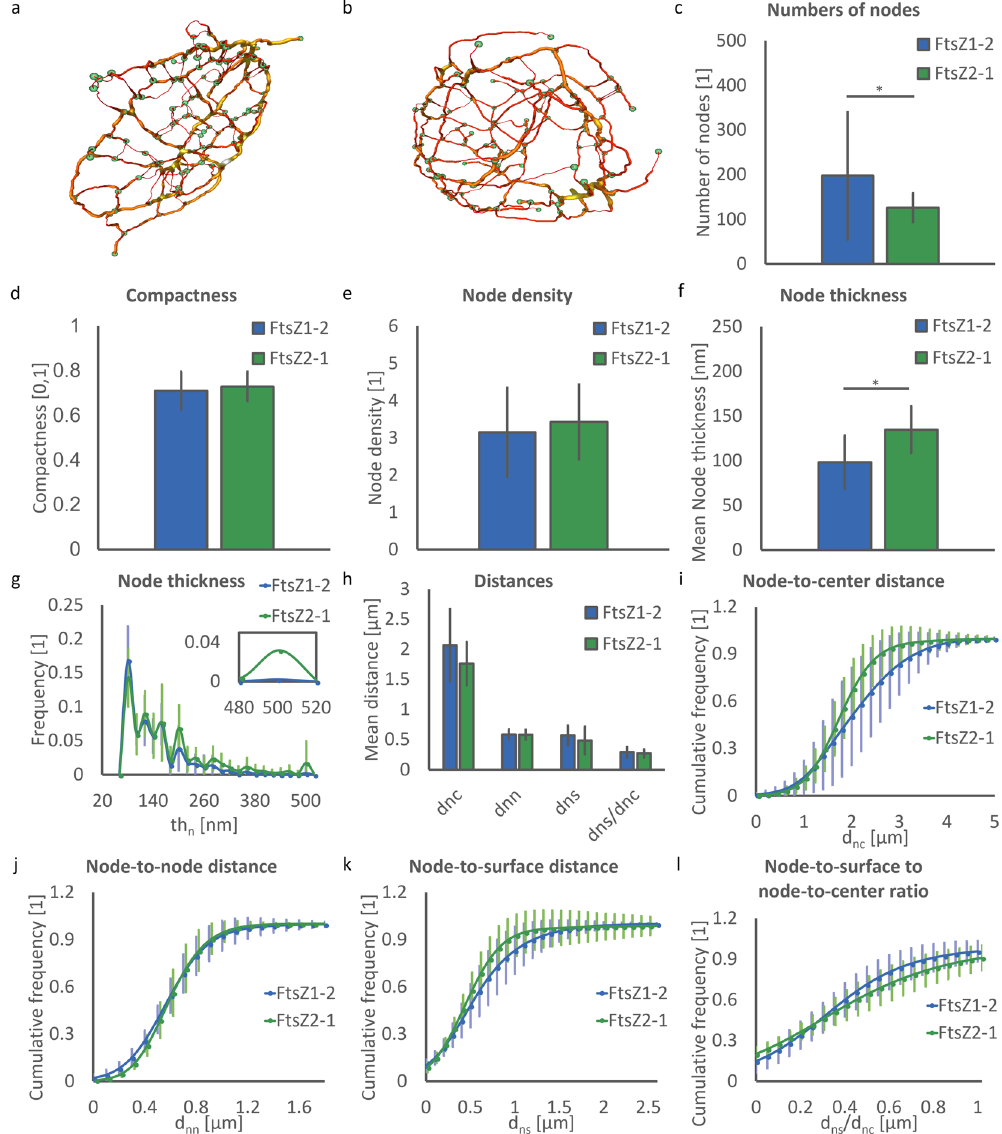
Figure 5. Spatial graphs and evaluated nodal parameters of FtsZ1-2 and FtsZ2-1. ( a ) A sample spatial graph of a FtsZ1-2 network. ( b ) A sample spatial graph of a FtsZ2-1 network. Nodes in both networks of ( a ) and ( b ) are shown in green spheres. The segments are colour coded based on their thickness with red (thinner segments) → yellow (thicker segments). ( c ) Number of nodes. ( d ) Compactness of the network. ( e ) Node density. ( f ) Mean values of node thickness per network. ( g ) Normalized distribution of node thickness. Inset shows the sizes of meganodes. ( h ) Mean values of node-to-centre distance per network, node-to-node distance, node-to- surface distance and node-to-surface to node-to-centre distance ratio. ( i ) Normalized cumulative distribution of node-to-centre distance. ( j ) Normalized cumulative distribution of node-to-node distance. ( k ) Normalized cumulative distribution of node-to-surface distance. ( l ) Normalized cumulative distribution of node-to-surface to node-to-centre distance ratio. ( c – l ) A total of 40 networks (20 networks for each isoform) were used for each statistical analysis. Each network corresponds to a distinct chloroplast. For each plot FtsZ1-2 and FtsZ2-1 are represented in blue and green, respectively, and data is shown as mean ± standard deviation. In the bar plots * indicates significant difference between isoforms. ( c – e ) One value per network. ( f , h ) Mean of all nodes per network. ( g ) Normalized distribution of all nodes per network. ( i – l ) Normalized cumulative distribution of all nodes per network. ( g – l ) n = 3947 and 2526 nodes for FtsZ1-2 and FtsZ2-1 analysed,